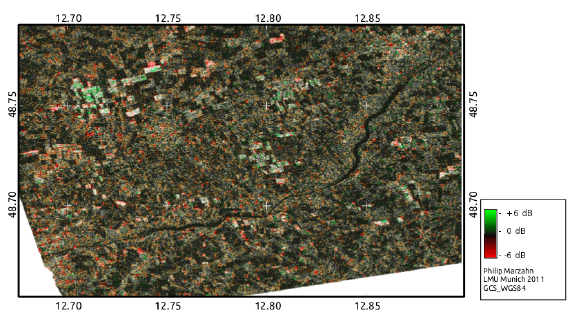
Figure 5: HSI (HueSaturationIntensity) composite of the backscatter ratio (hue), backscatter change (saturation) and backscattering in the first image of the pair (intensity) over Wallerfing site on 23 of May 2011. Backscatter ratio (hue) ranges from 6 to + 6 dB; mean intensity (intensity) from 22 dB to + 6 dB; absolute backscatter change (saturation) from 0 to + 6 dB. Red indicates higher intensity for the sub look 1, and green higher intensity for sub look 5.